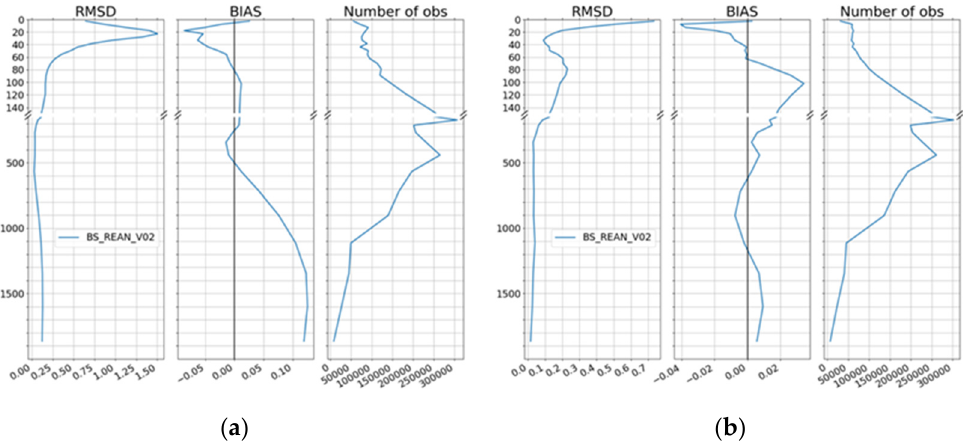
Figure 5. Vertical profiles of the root mean square deviation (left panel), bias (middle panel), and number of observations (right panel) for ( a ) temperature (°C) and ( b ) salinity (PSU) by comparing the reanalysis results with in situ profilers in the Black Sea domain from 1 January 1993 to 31 December 2019.